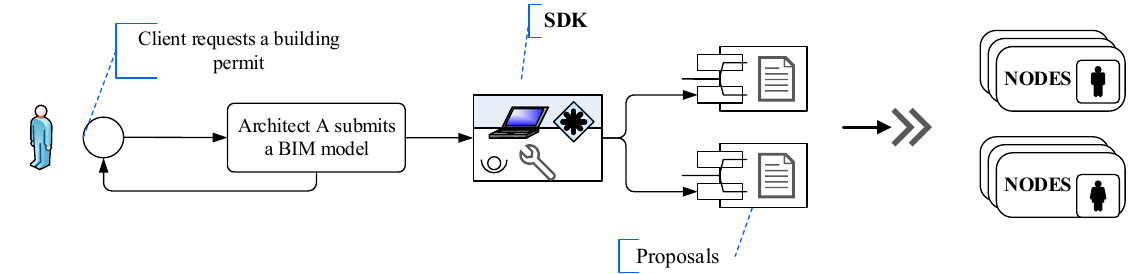
Figure 9. Data exchange initiation between an architect (owner) and building authority.